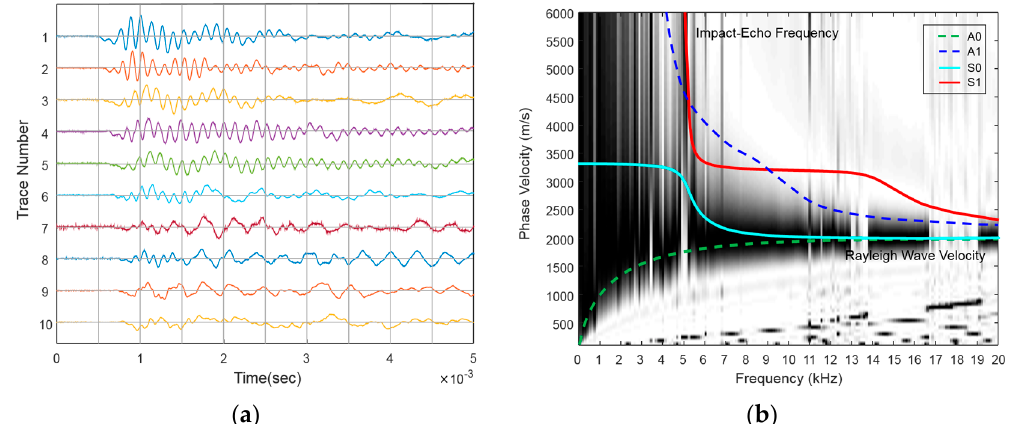
Figure 8. Experimental MASW results along Path III in specimen W2. The computed A0, A1, S0 and